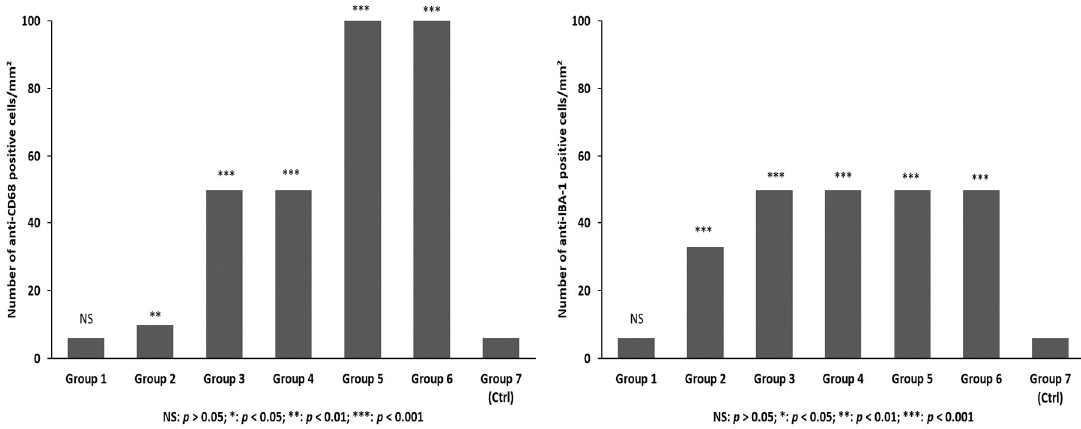
Figure 11. CD68 and IBA-1 immunopositivity. The differences between multiple groups were assessed using a one-way ANOVA with a significance level at p < 0.05. Post-hoc comparison between groups was further detected using the LSD method.